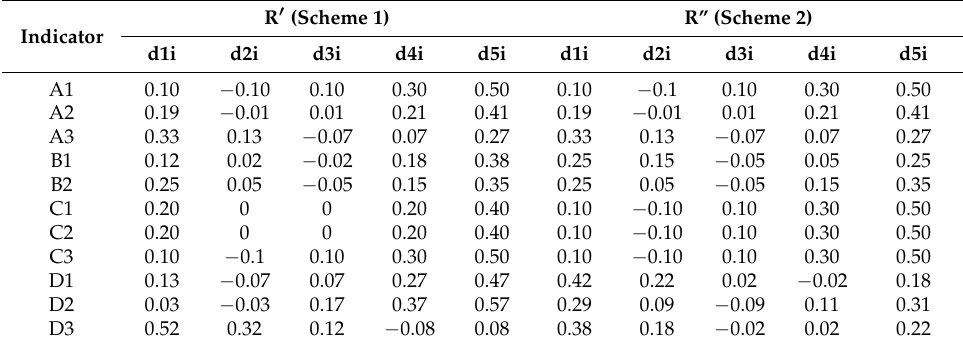
Table 15. Distance between the matter-element to be evaluated and classical domain.